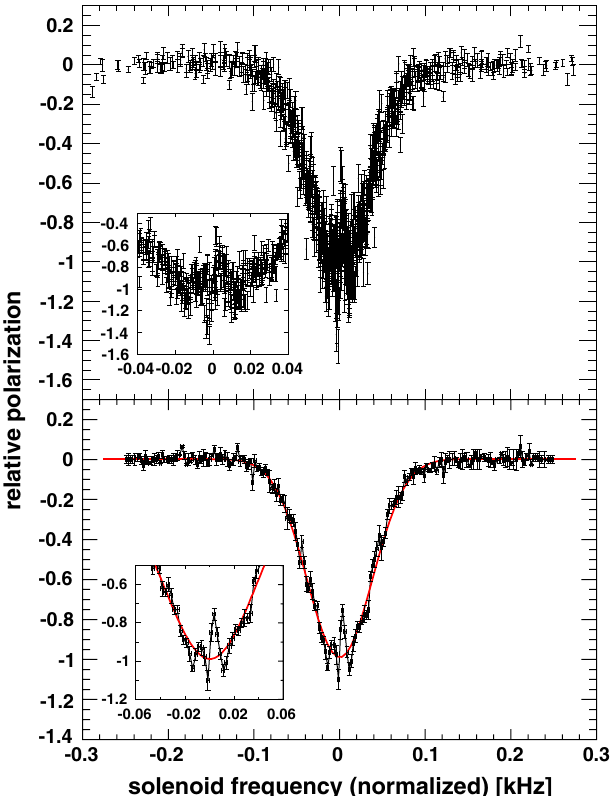
FIG. 4. (Color) Panel (a): The spin-resonance spectra normal- ized by a Gaussian. Panel (b): The same but with larger bins. The spin-resonance shape is symmetric about zero and smooth except in the center, where a double peak structure is seen. The structures, especially the double peak in the center, are caused by the interaction of the deuteron beam with the bb cavity. The insets show the resonance valley in greater